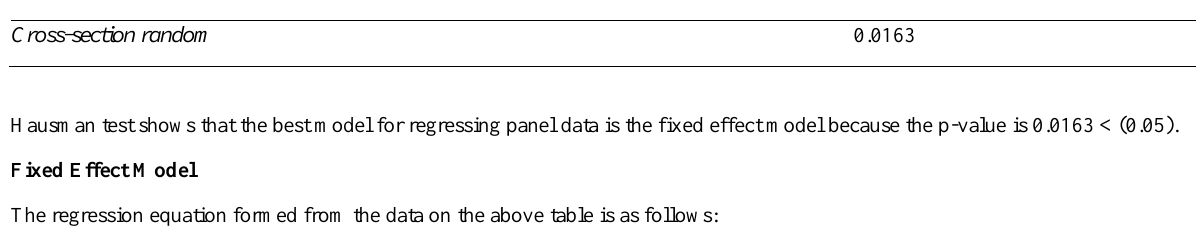
Table 3: Hausman Test Result